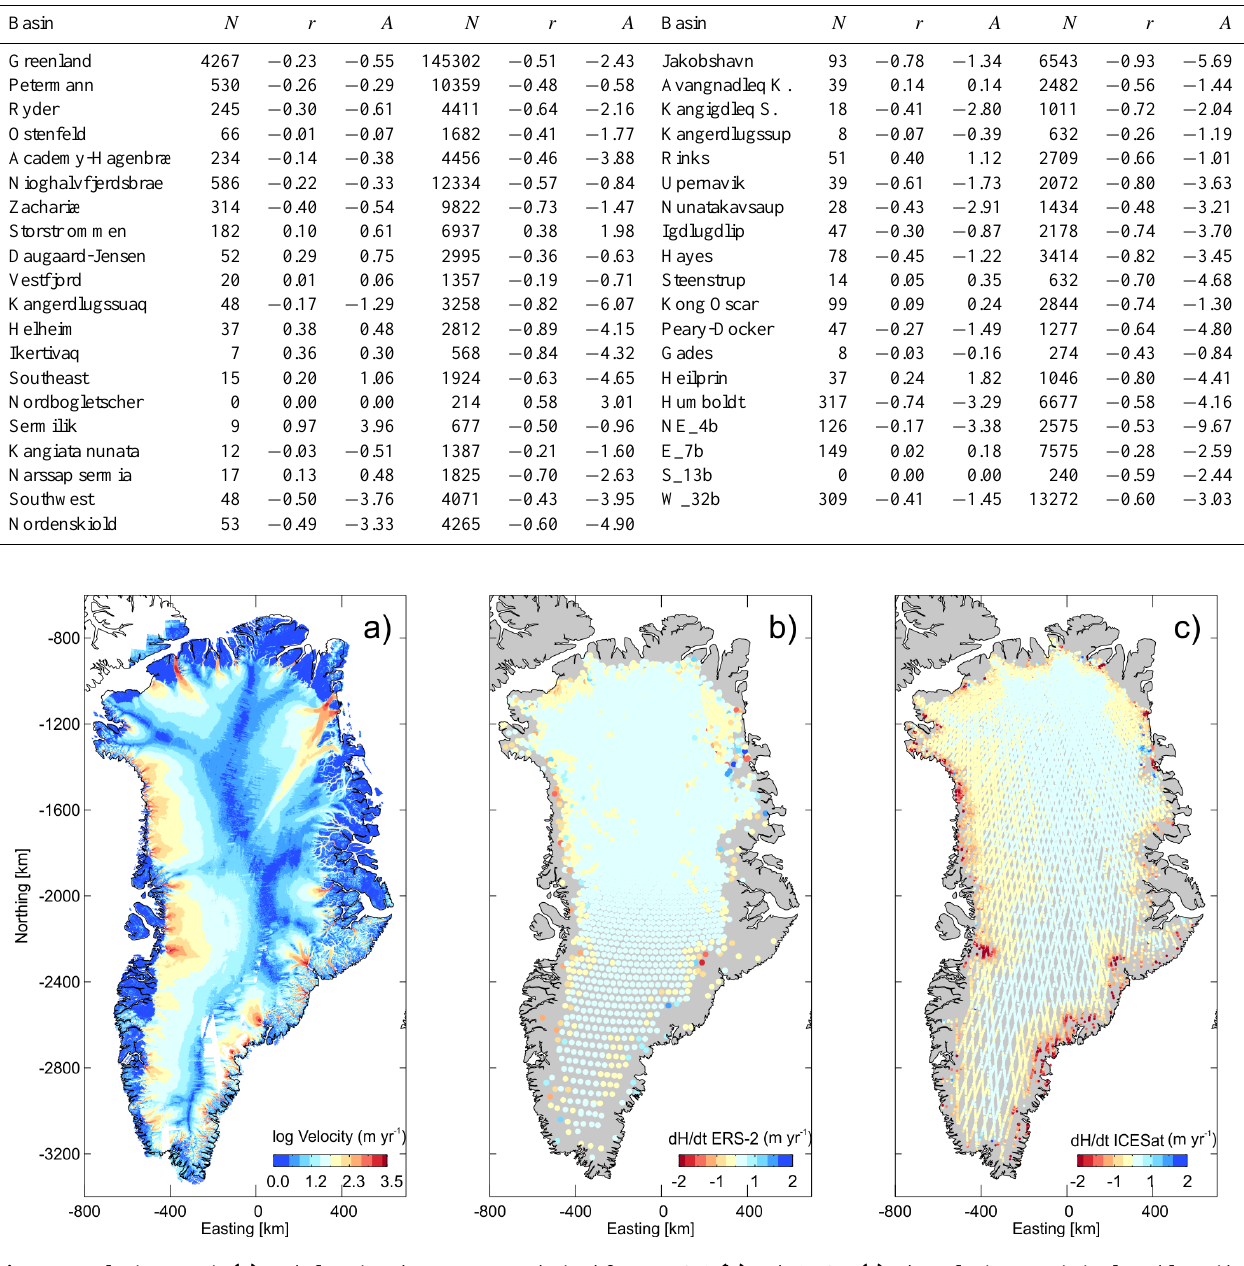
Figure 1. Velocity mosaic (a) , and elevation change rates as derived from ERS-2 (b) and ICESat (c) . The velocity mosaic is plotted logarith- mically for clarity and represents the average for the years 2000 and 2005–2008. The data used to calculate the elevation change rates in (b) and (c) are from 1995–2003 and 2003–2009,